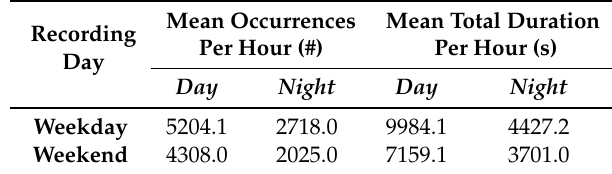
Table 3. Mean number of occurrences and total duration per hour obtained for the weekday and weekend day, distinguishing between day and night-time periods, and being the diurnal period defined as 06:00–22:00 [29], and averaging the features by the number of sensed hours per